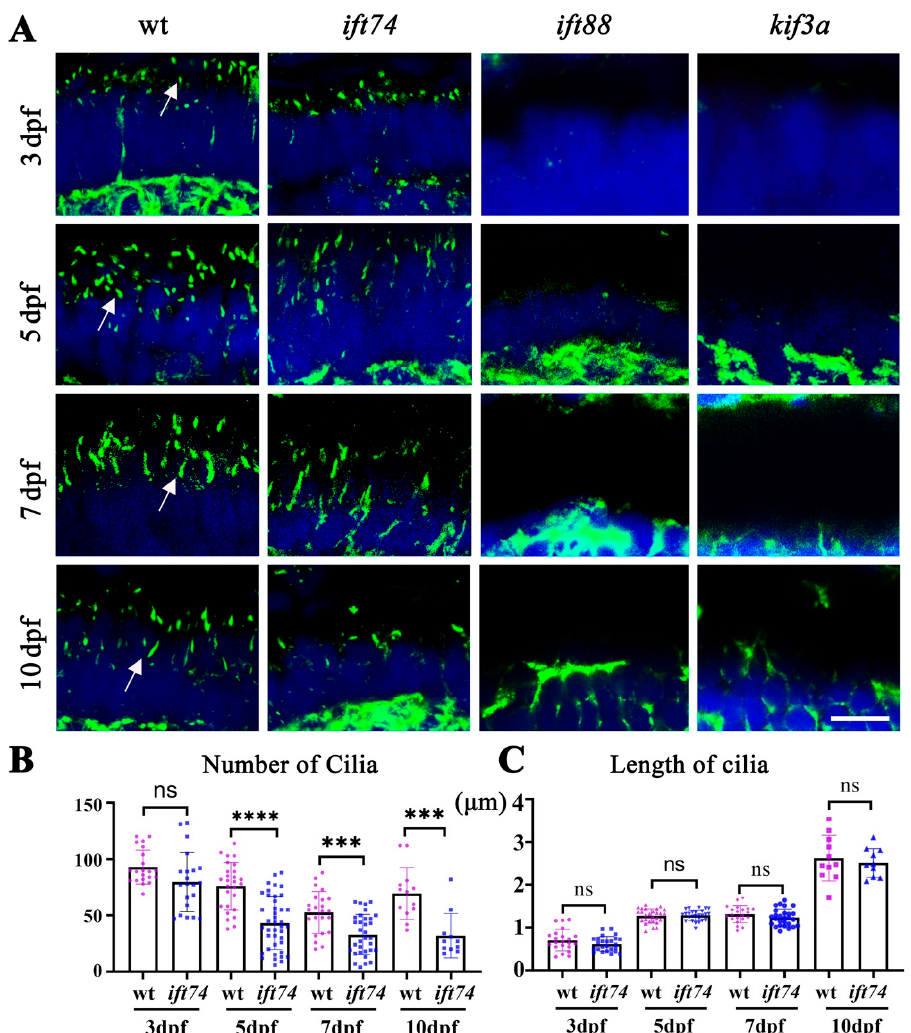
Figure 4. Photoreceptor connecting cilia in ift74 , ift88, and kfi3a mutants. ( A ) Confocal images showing photoreceptor connecting cilia in the retinae of wild-type and mutant larvae at different stages as indicated. Cilia were stained with anti-acetylated alpha tubulin antibody (green). Arrows indicate the connecting cilia. ( B , C ) Dot plots showing the number and length of connecting cilia in different groups as indicated. Scale bar: 10 µ m. *** p < 0.001, **** p < 0.0001, ns, no